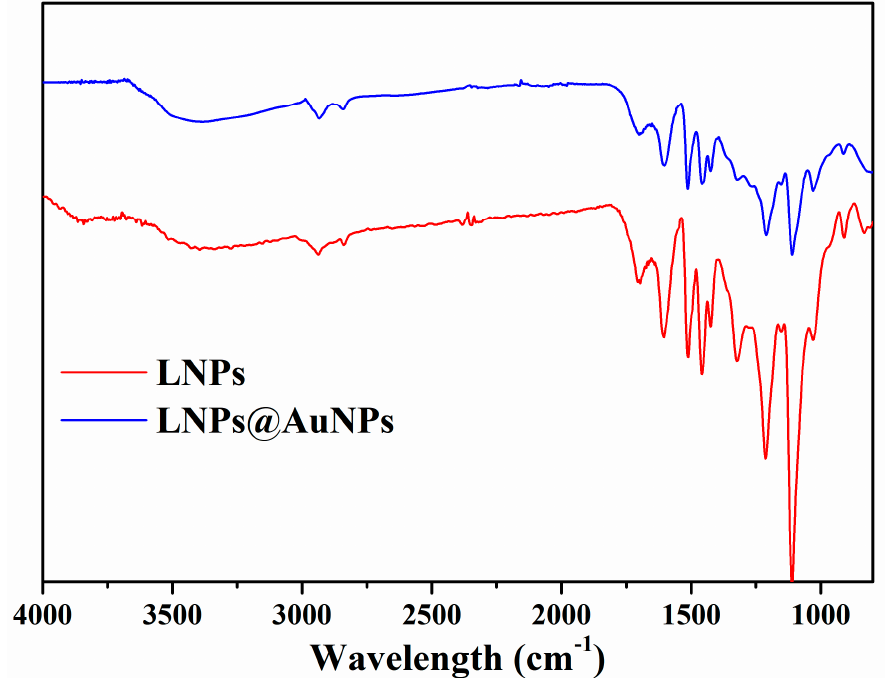
Figure 3. FTIR spectra of the LNPs and LNPs@AuNPs.